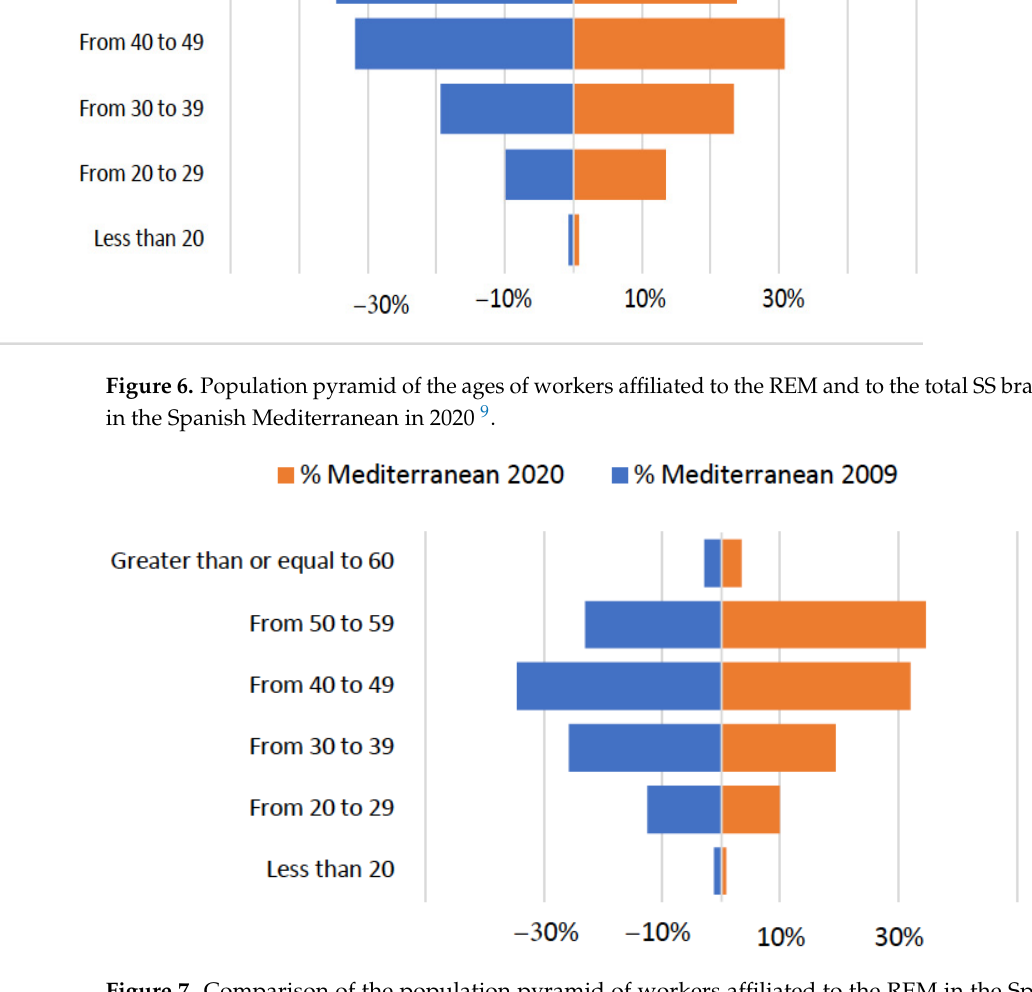
Figure 6. Population pyramid of the ages of workers affiliated to the REM and to the total SS branches in the Spanish Mediterranean in 2020 9 .